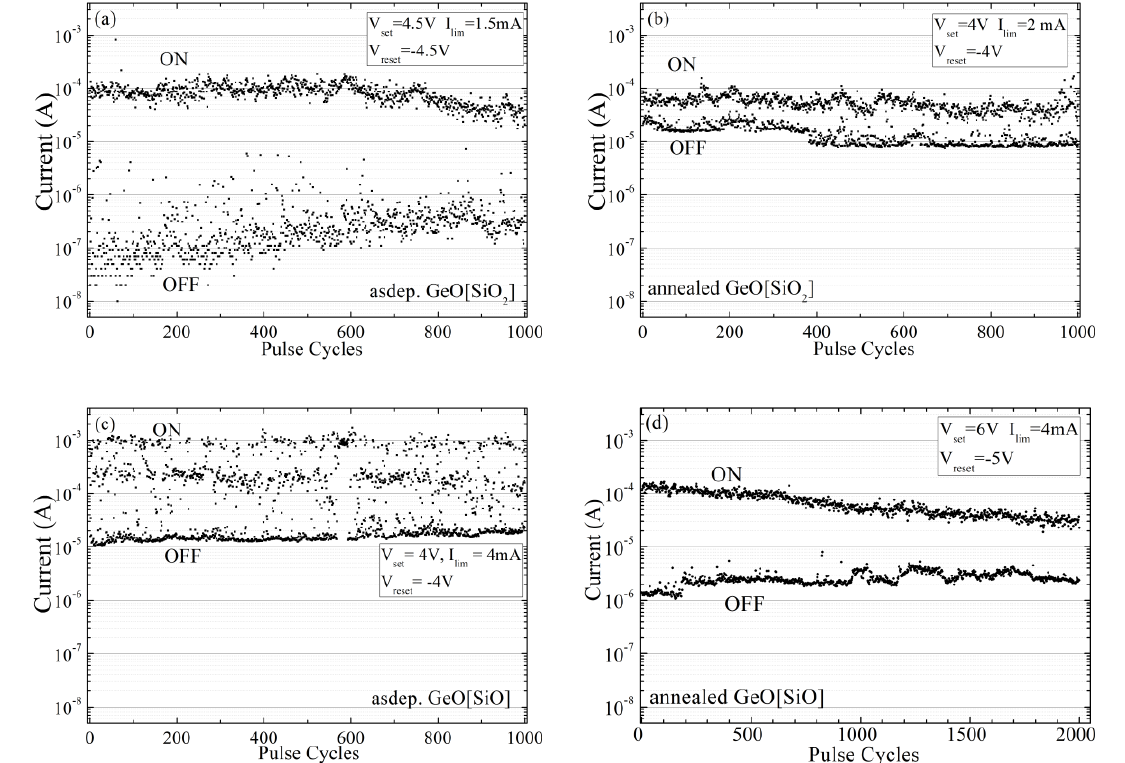
Figure 7. The endurance characteristics of the MIS structures. ( a ) As-deposited ITO/GeO[SiO 2 ]/p + -Si (001) heterojunction; ( b ) Annealed ITO/GeO[SiO 2 ]/p + -Si (001) heterojunction; ( c ) As-deposited ITO/GeO[SiO]/p + -Si (001) heterojunction; and ( d ) annealed ITO/GeO[SiO]/p + -Si (001) heterojunction.